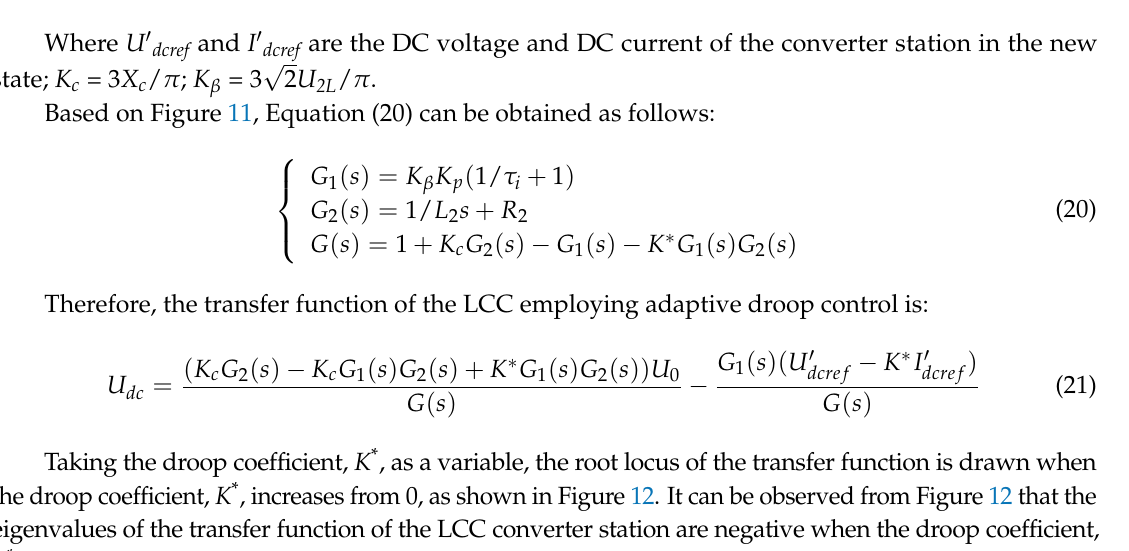
Figure 11. Transfer function block diagram of LCC employing adaptive droop control.